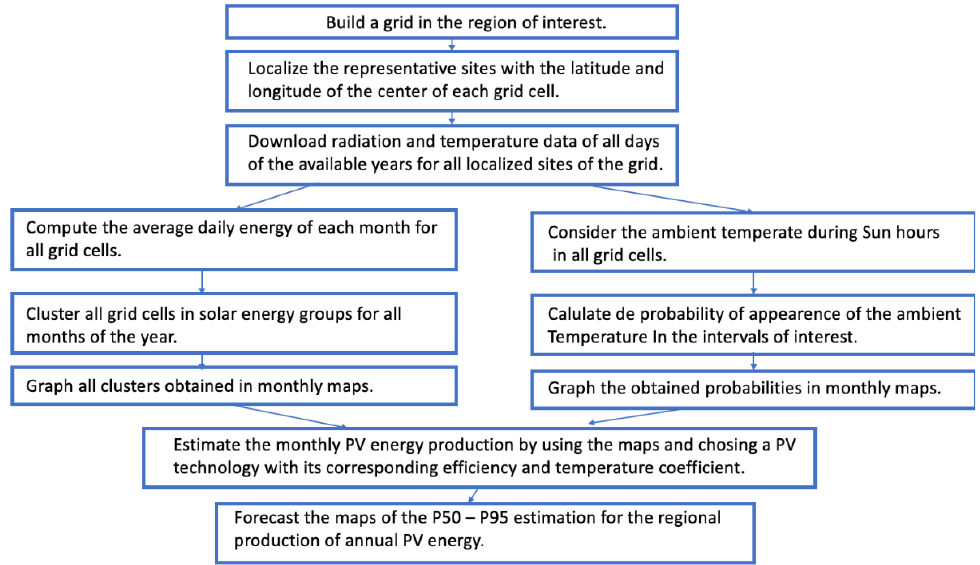
Figure 2. Methodology to obtain a regional map of mean daily solar energy and a map of probability of occurrences of high temperatures per month, and the atlases to forecast the annual PV production in a region using 𝑃50 – 𝑃95 estimations.